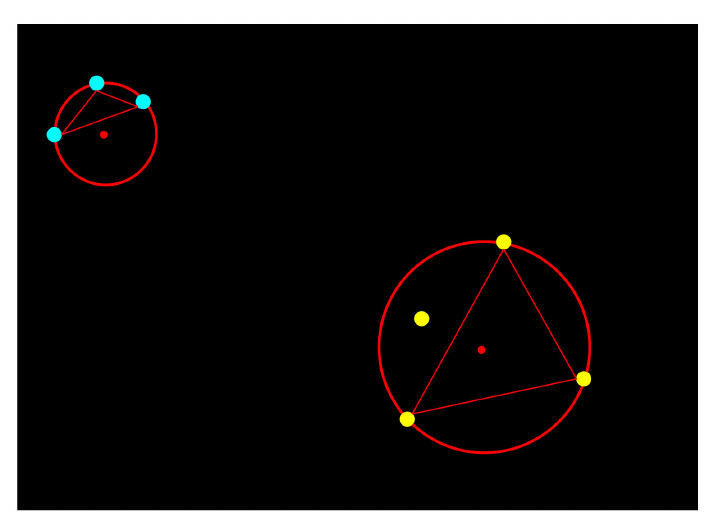
Figure 6. Circumscribed circle calculation.